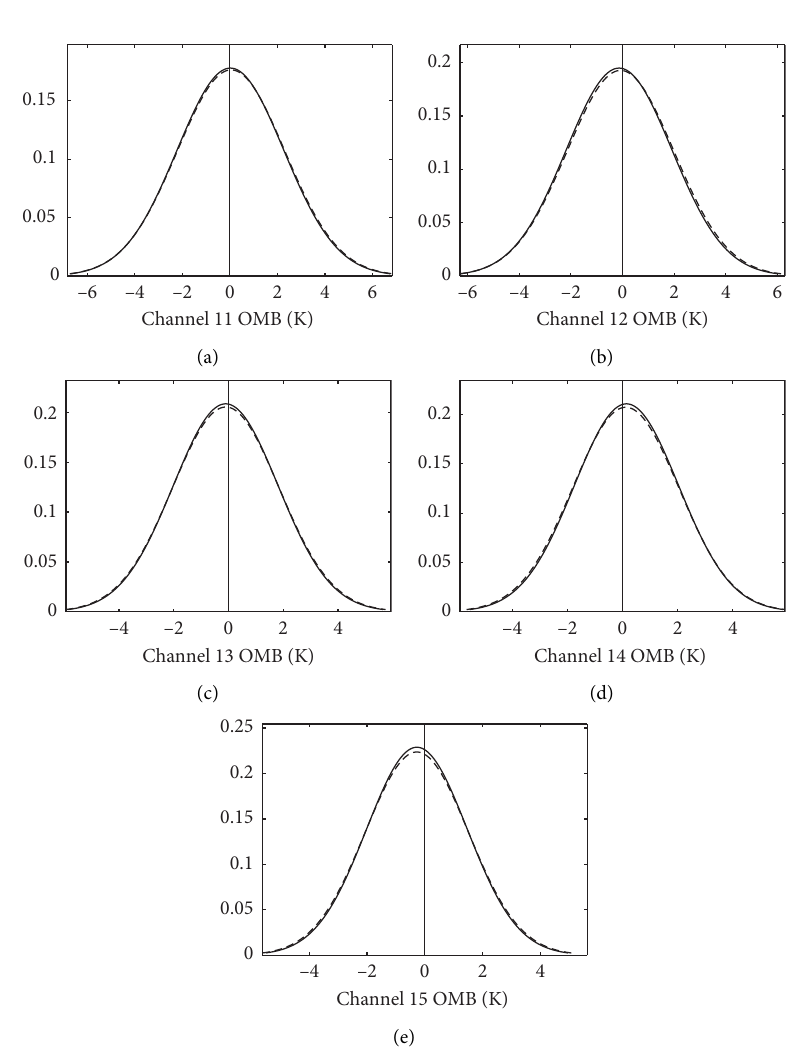
Figure 4: The PDF distributions of the first-guess departures of assimilated observations which are in the AL (dashed line) and DY (bold line) experiments from 0000 UTC 23 June to 0000 UTC 25 June for channels 11–15